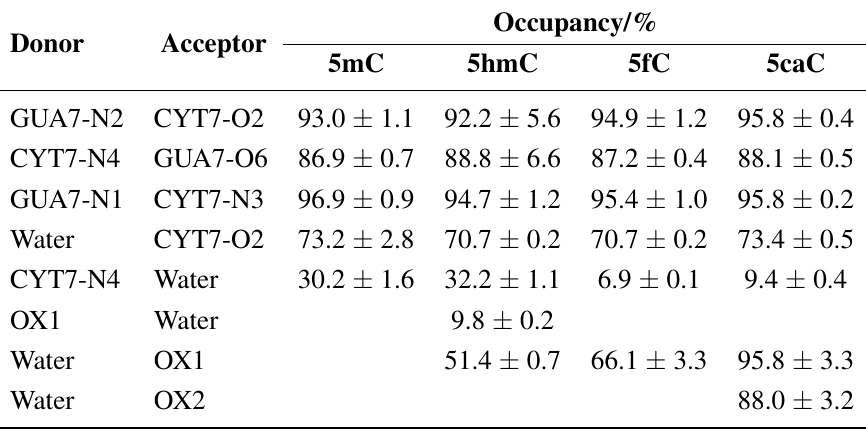
Table 1. Occupancies of hydrogen bonds between DNA base pairs computed from the sim- ulation of 5-methyl-cytosine (5mC), 5-hydroxymethyl-cytosine (5hmC), 5-formyl-cytosine (5fC) and 5-carboxyl-cytosine